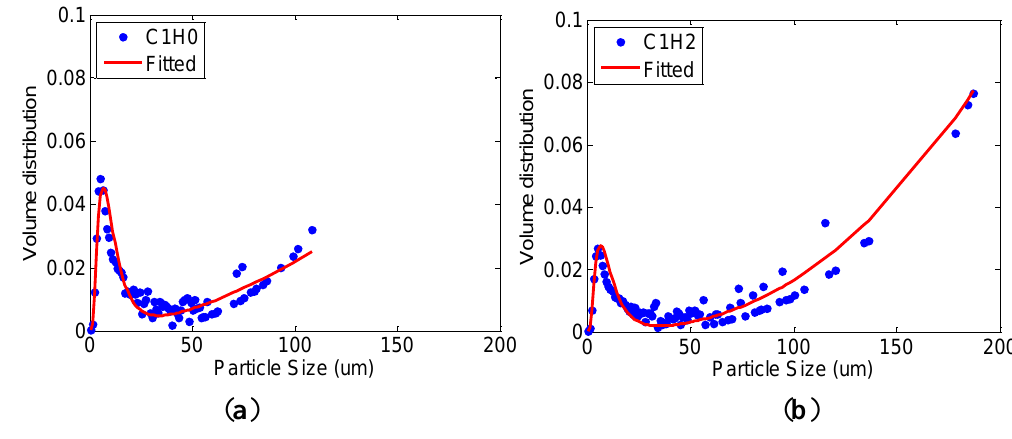
Figure 5. Volume distributions of mix C1 at ( a ) 0 h and ( b ) 2 h after